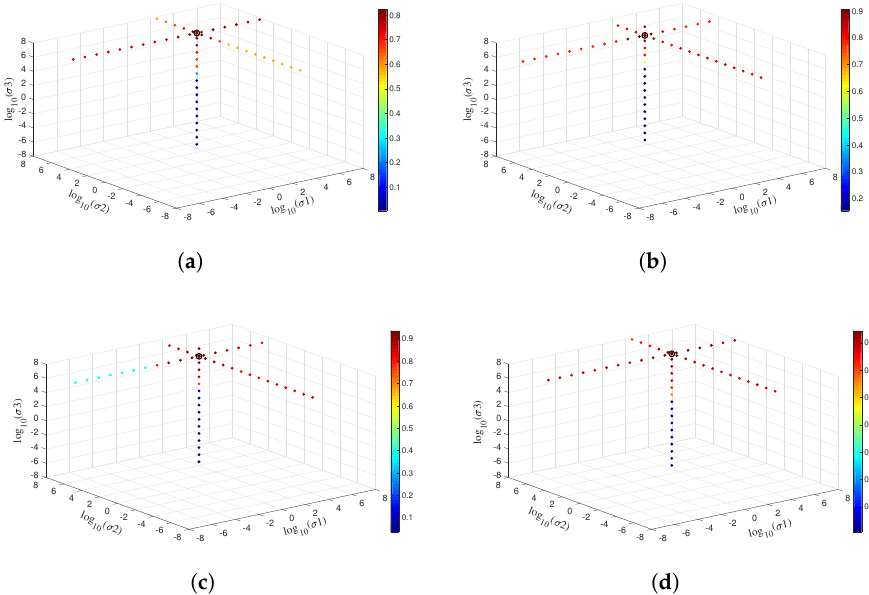
Figure 12. Parameters tuning of DKELM in ( a ) Indian pines, ( b ) University of Pavia, ( c ) Salinas, and ( d ) Glycine ussuriensis